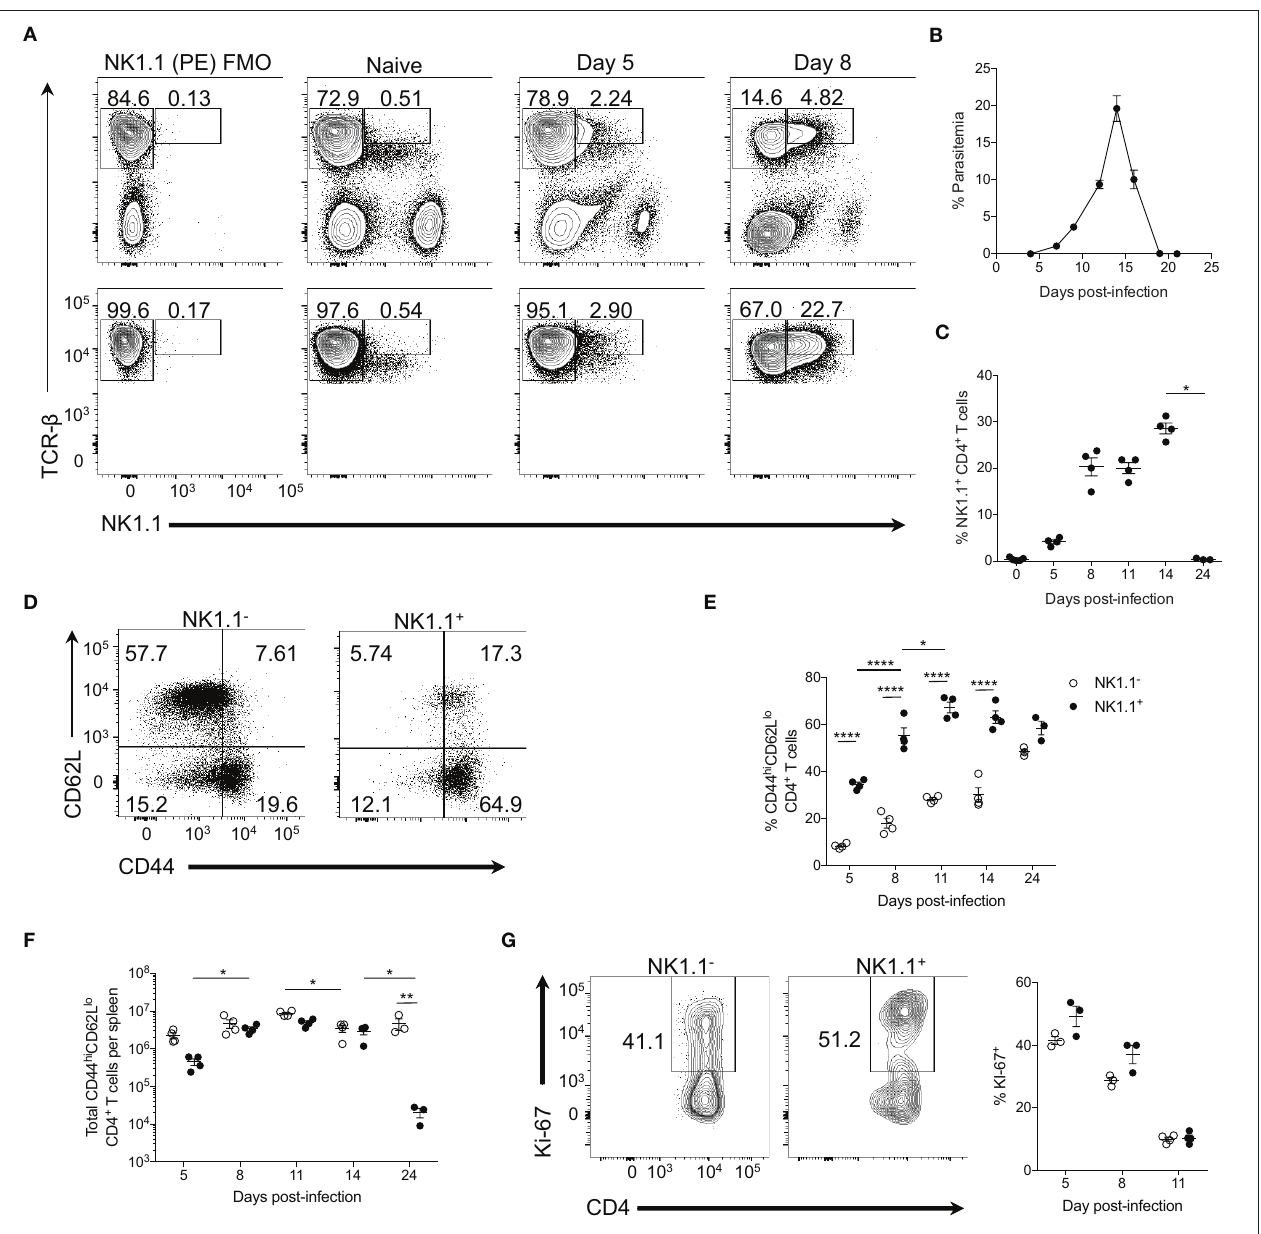
FIGURE 1 | NK1.1 + CD4 + T cells expand during acute P. yoelii infection. (A) Top: Representative TCR β and NK1.1 expression at days 5 and 8 post- P. yoelii infection. Gated on live splenocytes. Bottom: Representative plots that were previously gated on live, CD4 + TCR β + splenocytes showing TCR β and NK1.1 expression at days 5 and 8 post- P. yoelii infection. FMO, fluorescence minus one staining control. (B) Peripheral blood parasitemia as determined by FACs. (C) Frequency of NK1.1 expression among live CD4 + TCR β + T cells. Significance assessed by one-way ANOVA Kruskal-Wallis test with post-hoc Dunn’s multiple comparisons test. * p < 0.05. (D) Representative CD44 and CD62L expression among live, NK1.1 positive and negative CD4 + TCR β + splenocytes at day 8 post-infection. (E) Frequency of CD44 hi CD62L lo of live CD4 + TCR β + T cells between days 5 and 24 post-infection. An aligned rank transformation was performed on non-parametric data